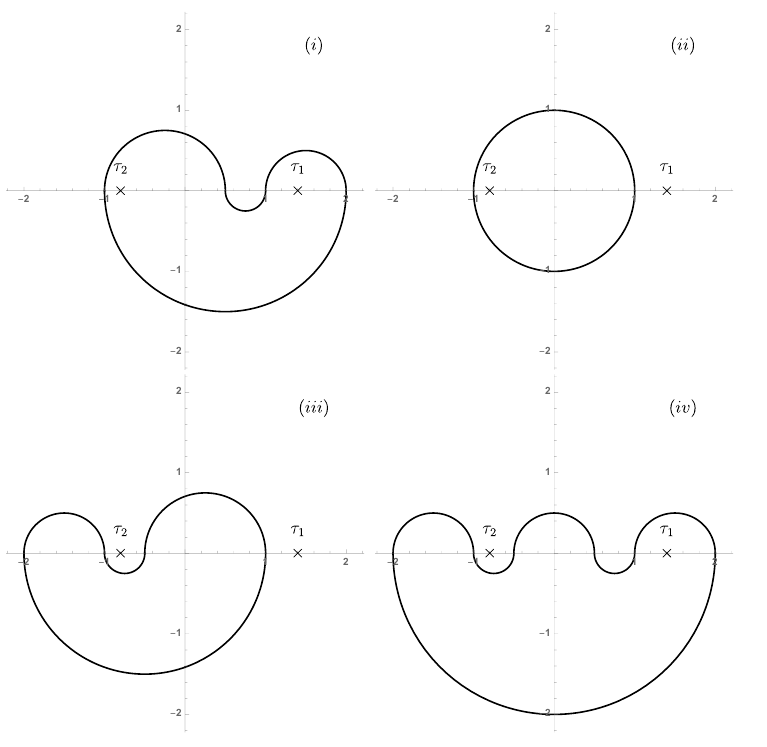
Figure 4. Four distinct choices of